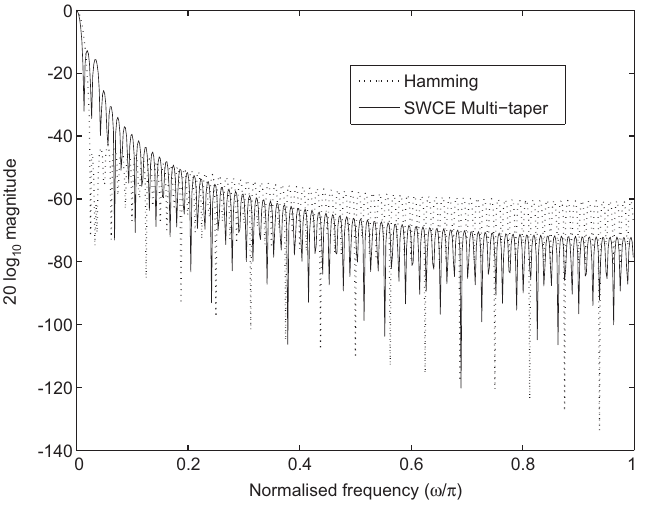
Figure 2. Frequency Domain for a Hamming Window and SWCE Multitaper Window.